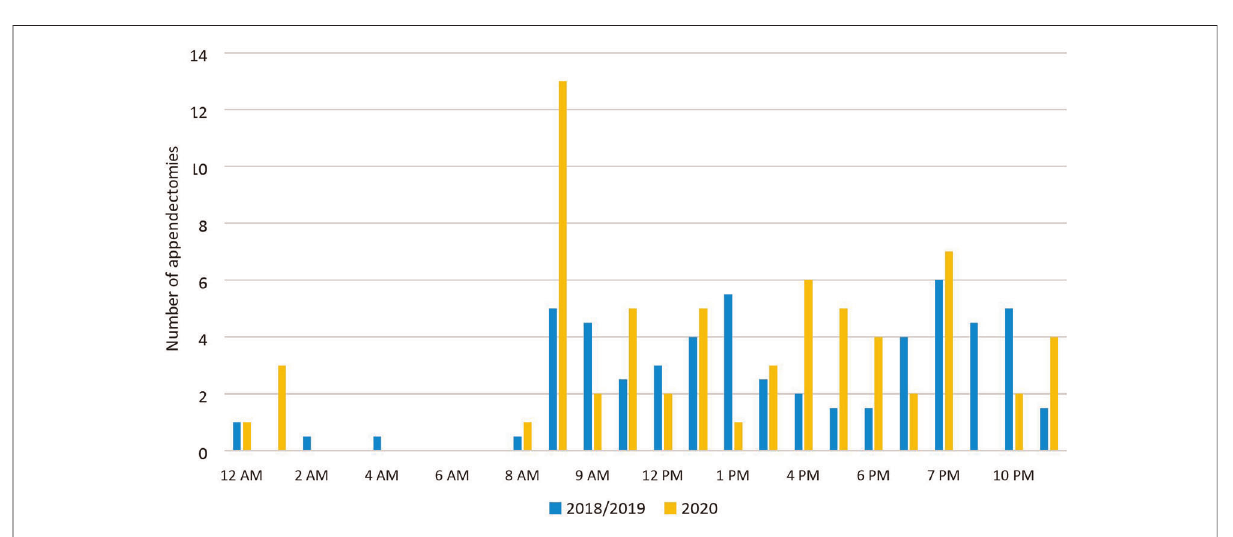
FIGURE 7 Distribution of appendectomies over a 24-h schedule in 2018/2019 and 2020.